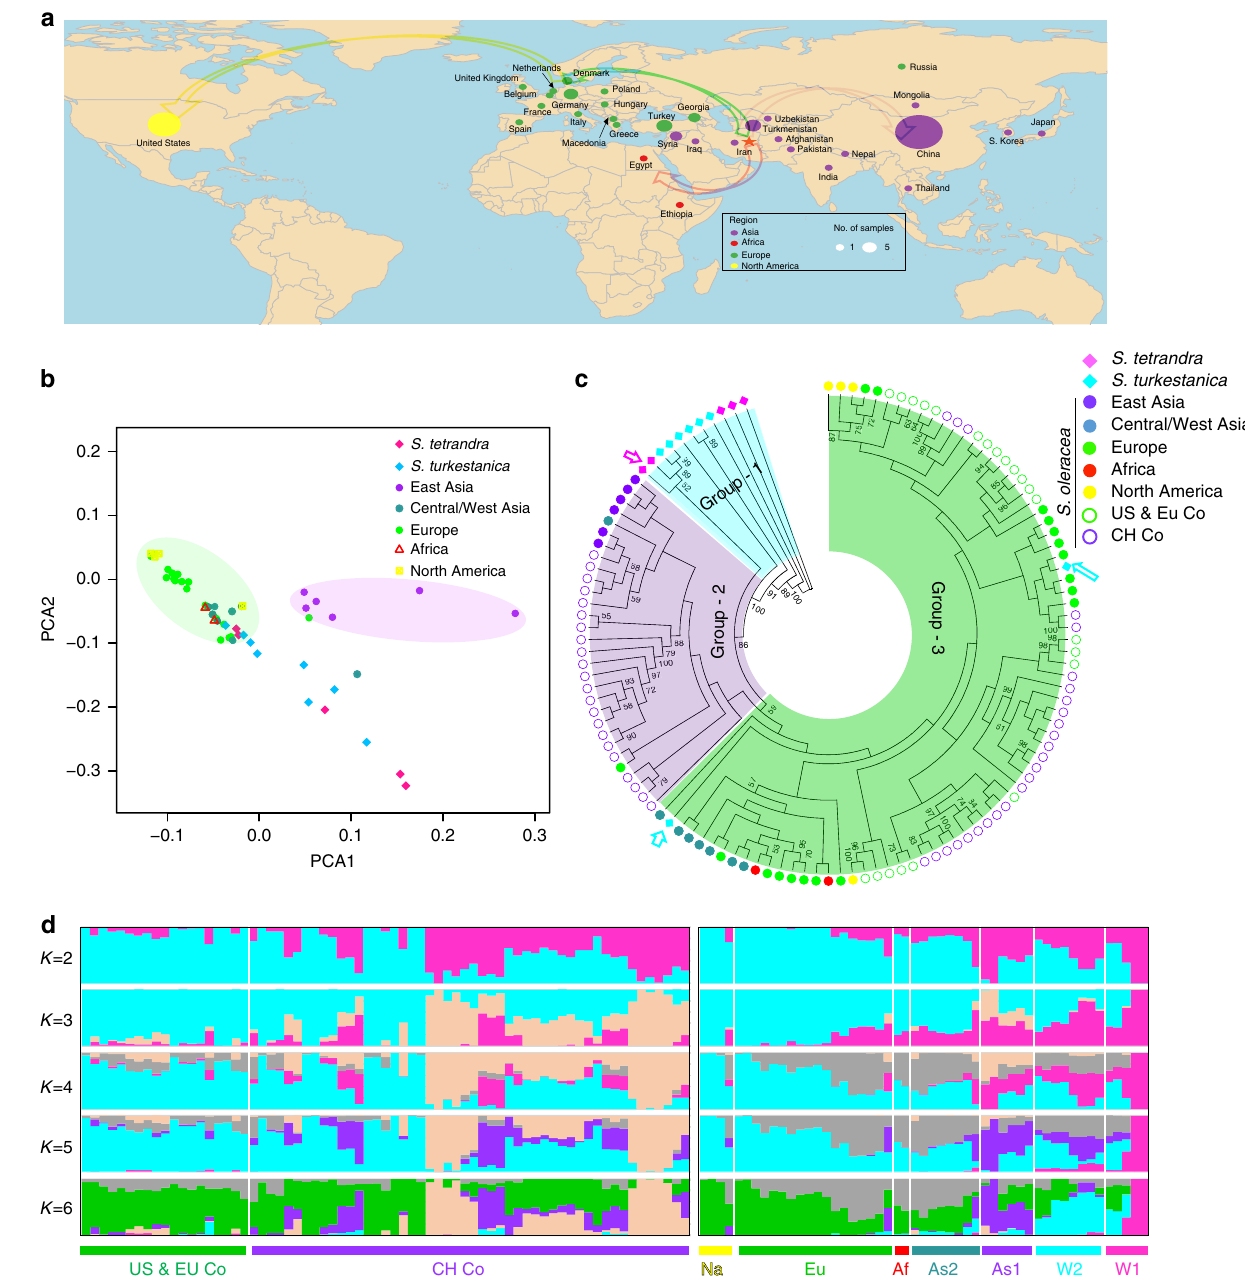
Figure 3 | Geographic distribution and population structure of the 120 spinach accessions. ( a ) Geographic information of the 120 accessions. The number of samples is represented by the dot size on the world map. The red star indicates the suggested origin location of spinach, and the arrows suggest the domestication history of spinach. Commercial cultivars provided by Chinese seed companies are plotted in China and commercial cultivars provided by American/European companies are plotted in United States. ( b ) PCA plot of non-commercial spinach accessions. ( c ) Phylogenetic tree of all spinach accessions inferred from transcriptome SNPs, with S. tetrandra Sp42 and Sp43 as the outgroup. The pink arrow indicates the two S. tetrandra (Sp39 and Sp40) that were grouped to S. turkestanica and the blue arrows indicate the two S. turkestanica (Sp47 and Sp48) that were clustered with cultivars. ( d ) Model-based clustering analysis of the 51 non-commercial (right) and 69 commercial (left) spinach accessions, given different number of groups ( K ¼ 2 to 6). The y axis quantifies subgroup membership, and the x axis shows different accessions. W1: S. tetrandra ; W2: S. turkestanica ; As1: East Asia; As2: Central/West Asia; Eu: Europe; Af: Africa; Na: North America; CH Co: companies in China; US & EU Co: companies in United States and